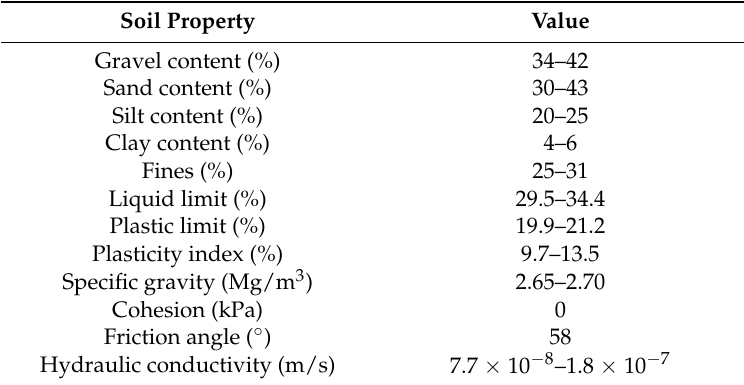
Table 4. Soil properties of the material used for the construction of the embankment.